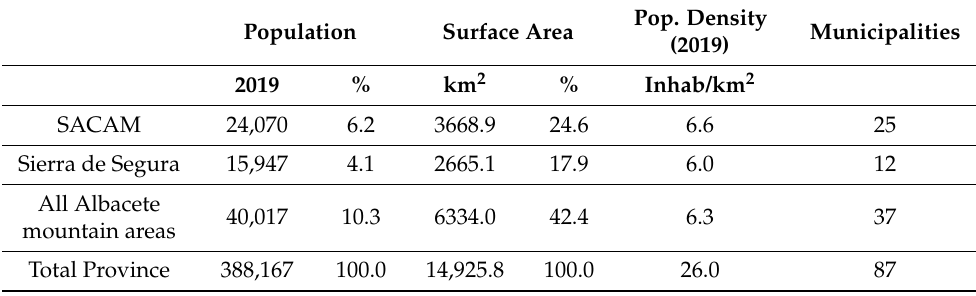
Table 2. Population and territory of the study area (Source: Inebase, 2020). Own preparation. Pop. Density Population Surface Area